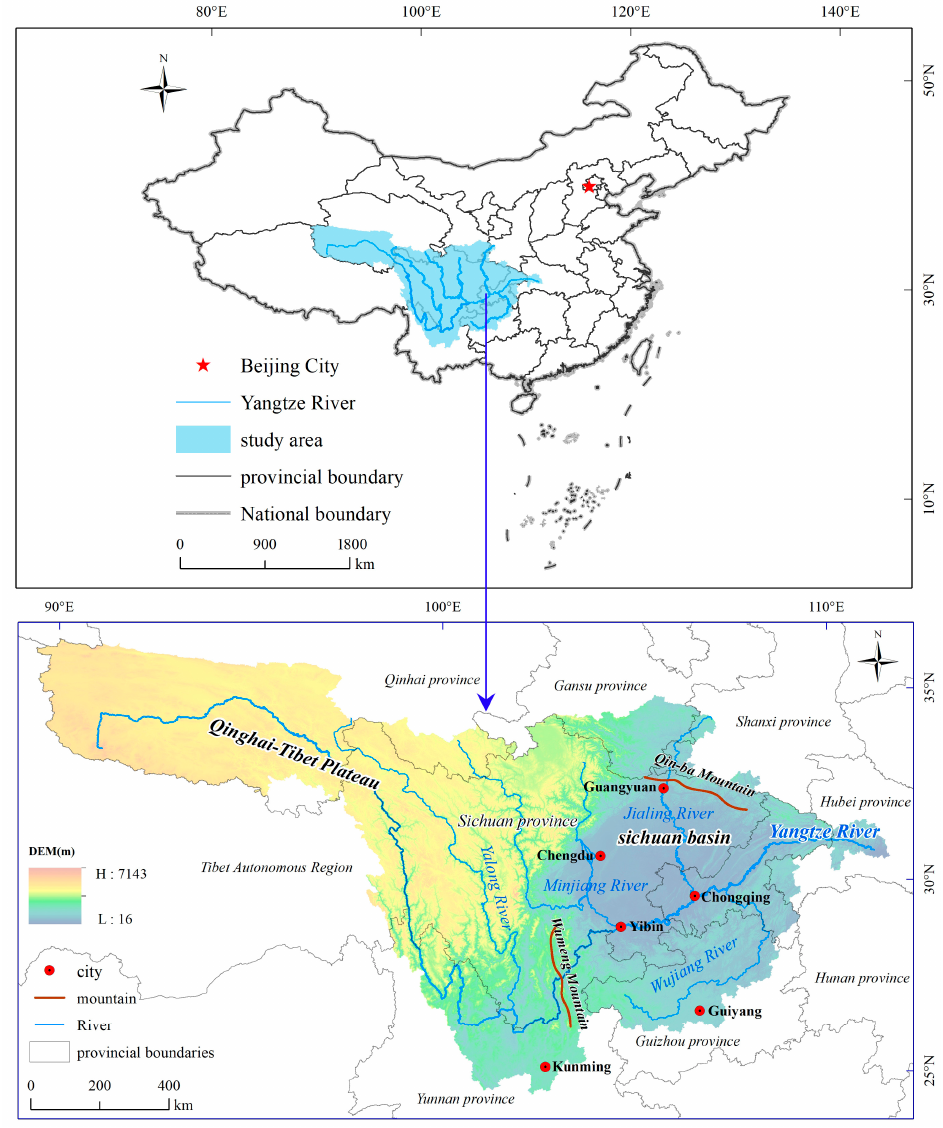
Figure 1. Location of the study